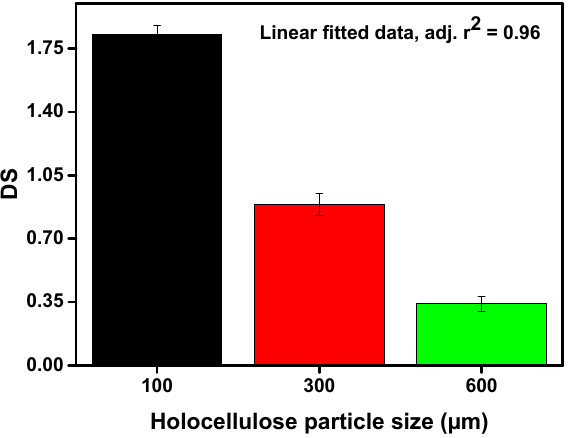
Figure 2. Degree of substitution of the synthesized CMC depending on varying particle size of holocellulose.